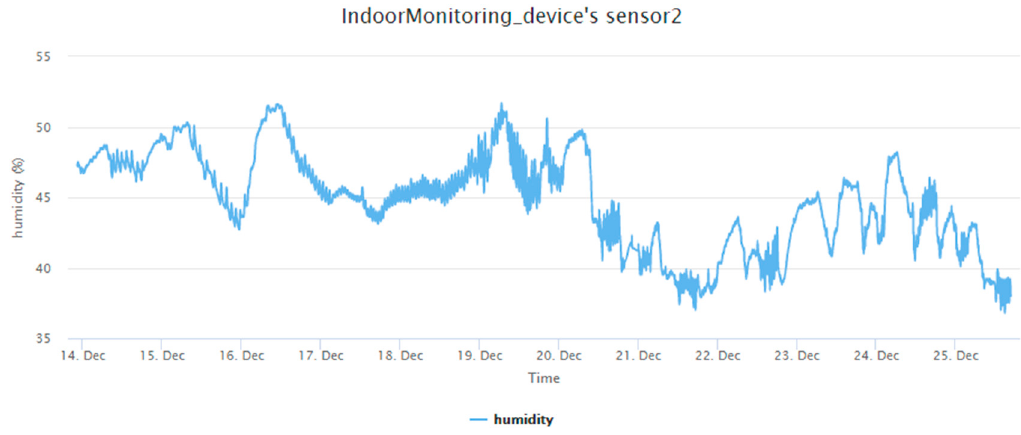
Sensors 2019 , 19 , 495 Figure 12. The temperature observations from the indoor monitoring device. Figure 12. The temperature observations from the indoor monitoring device.